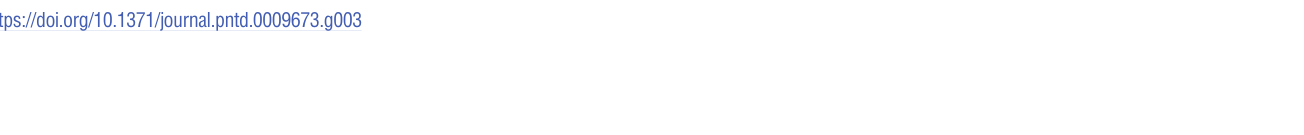
PLOS NeglectedTropical Diseases | https://doi.org/10.1371/journal.pntd.0009673 August 6, 2021 8 /